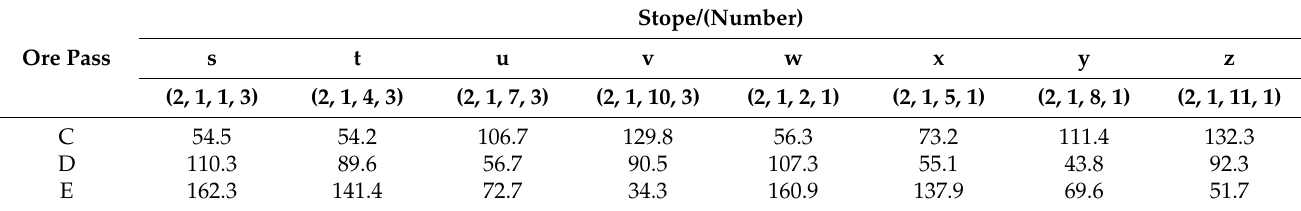
Table 5. Empty travel time of the scraper between the stope and ore pass in ( 2, 1 ) sublevel/s (Units: